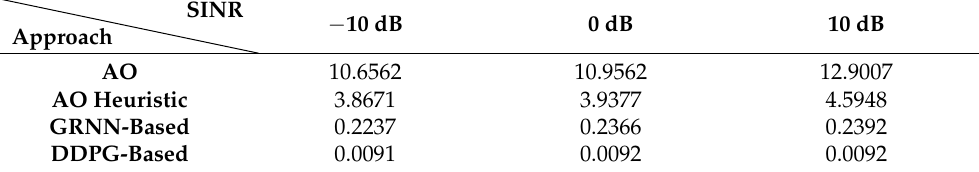
Table 3. Average prediction run time (seconds) for different SINR thresholds in static UE scenario.